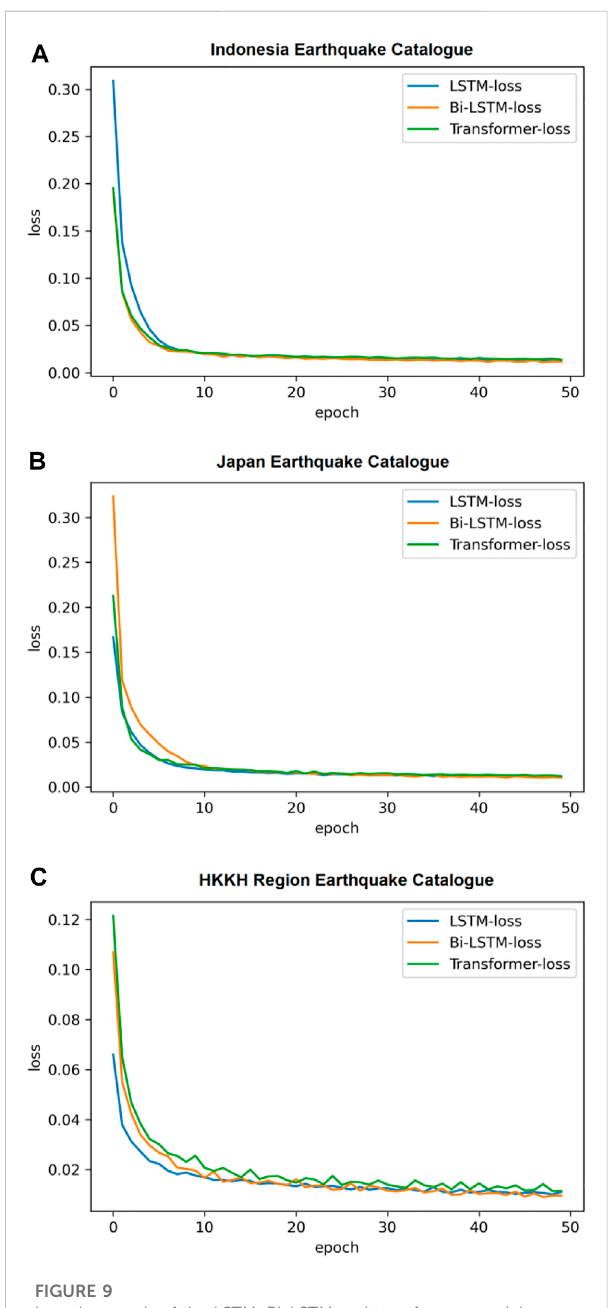
FIGURE 9 Learning graph of the LSTM, Bi-LSTM and transformer